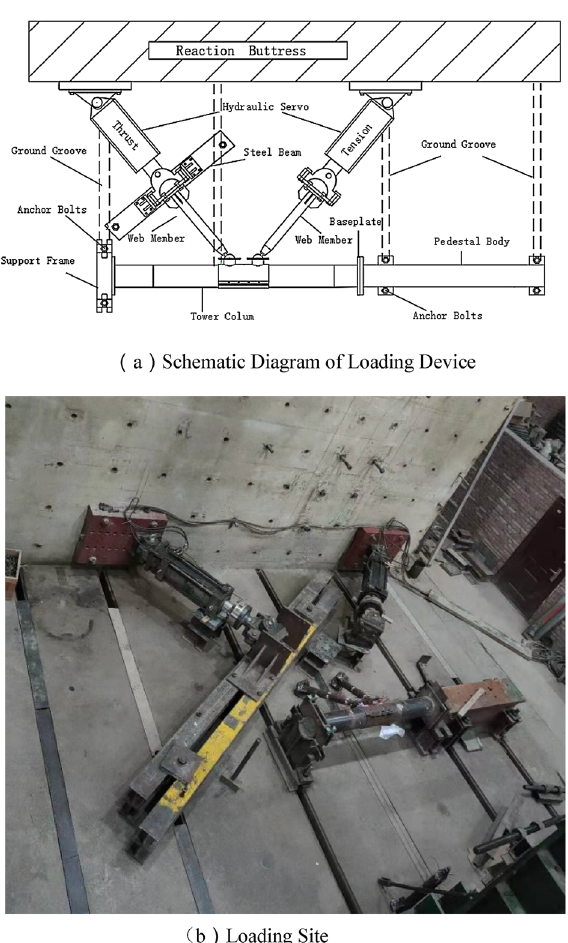
Figure 2. Loading